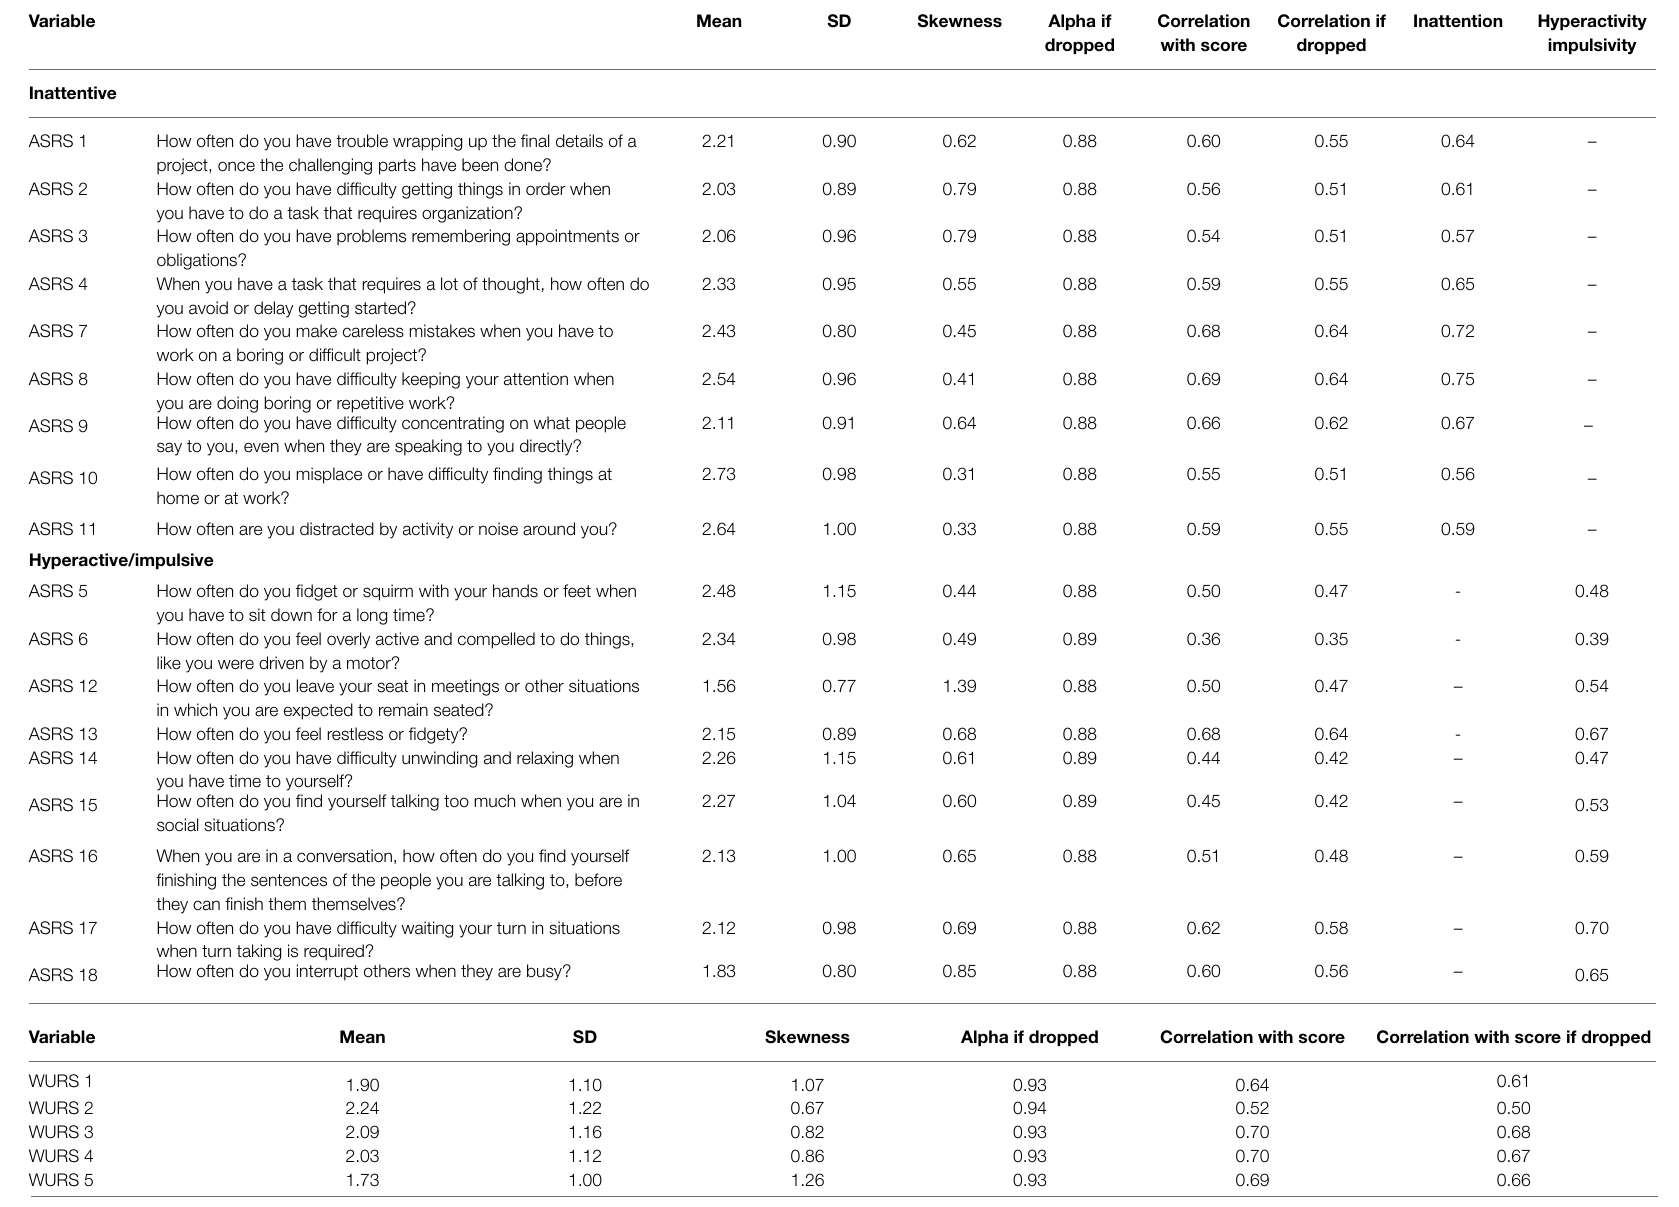
TABLE 2 | Item analysis (we also show the reliability of the test if the item was dropped and standardized factor loadings from the CFA for the symptom list). Variable Mean SD Skewness Alpha if